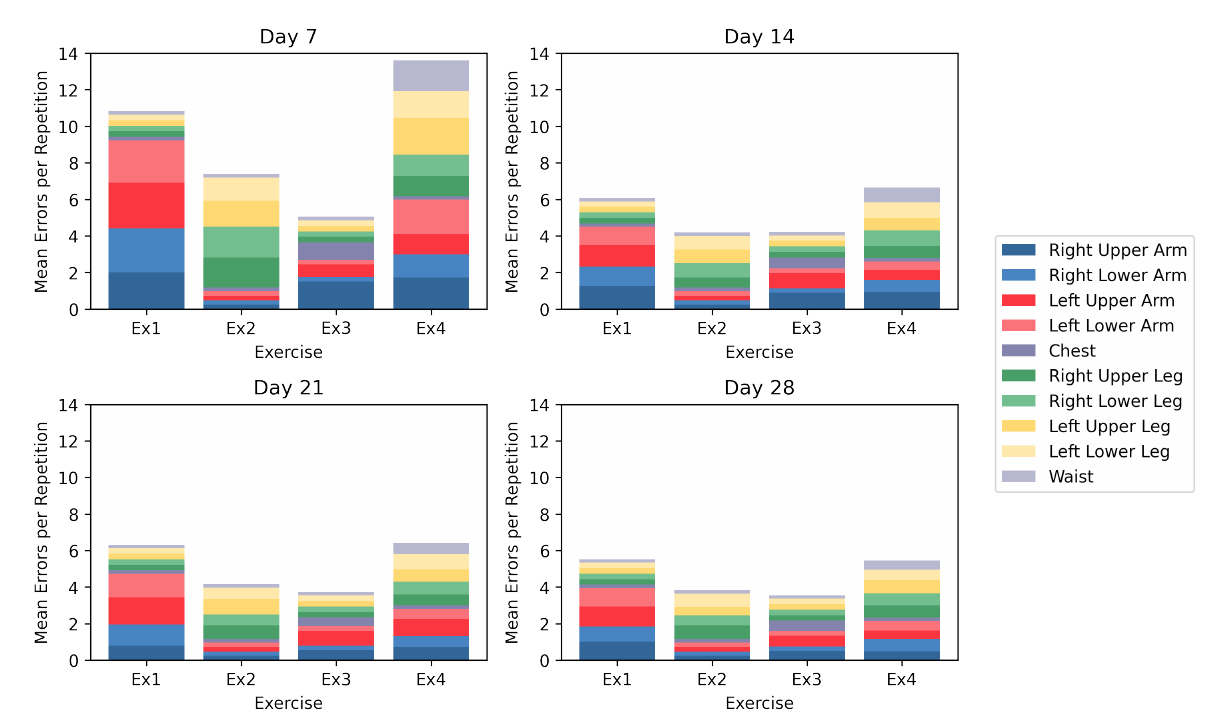
Figure 13. Average deviation for each part of the